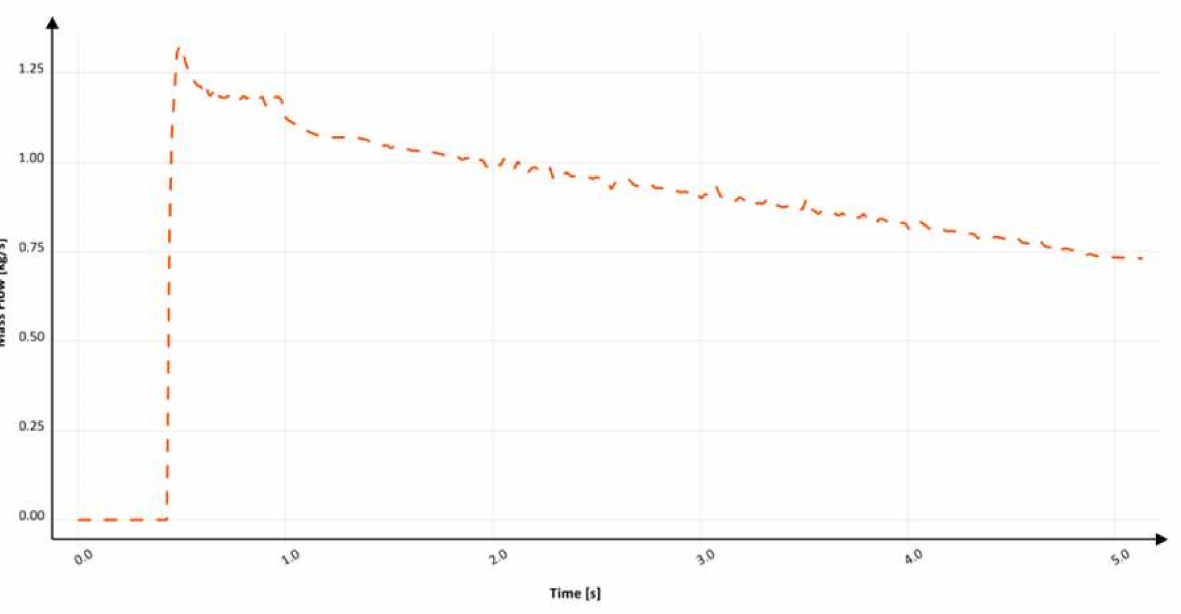
Figure 20. Mass flow through ingate with round, reverse tapered sprue with choke (Ss2), MAGMASOFT. The flow kinetics for the third solution (S s 3), which is a round sprue with a reverse taper without a choke, is shown in Figure 21. This design is also quite common in automatic molding lines with a horizontal parting plane. The initial fill phase before the stream reaches the first bend is similar to the previous design with a choke (S s 2); the presence of the choke is the only difference between these designs. After 308.8 ms, the formation of a sprue lake and back wave can be seen with air pockets that form veins. The pressurization of the runner is analogous to that of the first design (S s 1); the centrifugal force prevents the metal from flowing through the entire cross-section of the channel, creating a large free surface. After 482 ms, the runner is completely pressurized, whereas the sprue is pressurized at 689 ms. In this design, the maximum velocity of metal is close to free-fall velocity (3.71 m/s), as it exceeds 3.5 m/s.